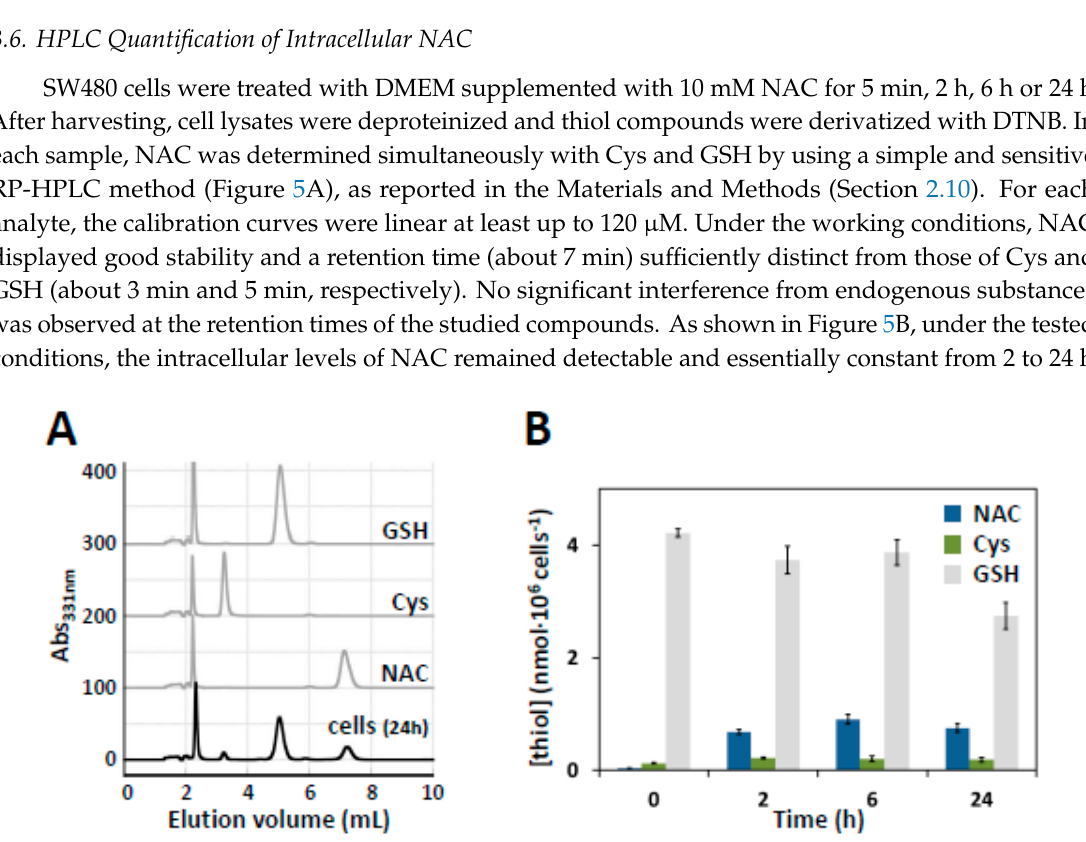
Figure 5. Intracellular NAC quantification by RP-HPLC. (Panel A ) SW480 colon cancer cells were treated with 10 mM NAC for 5 min, 2 h, 6 h and 24 h. Cell lysates were deproteinized and NAC was quantified by RP-HPLC simultaneously with Cys and GSH after DTNB derivatization. Representative chromatograms are shown. Calibrations (in gray) were performed by injecting standard solutions of GSH, Cys and NAC at known concentrations. In black it is reported a representative chromatogram obtained with cells treated with NAC for 24 h. (Panel B ) Data represent the mean values ± SD of two biological duplicates, each in technical duplicate.